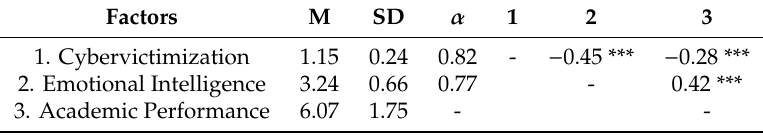
Table 1. Descriptive statistics, reliability analysis, and correlations between all variables. Factors M SD α